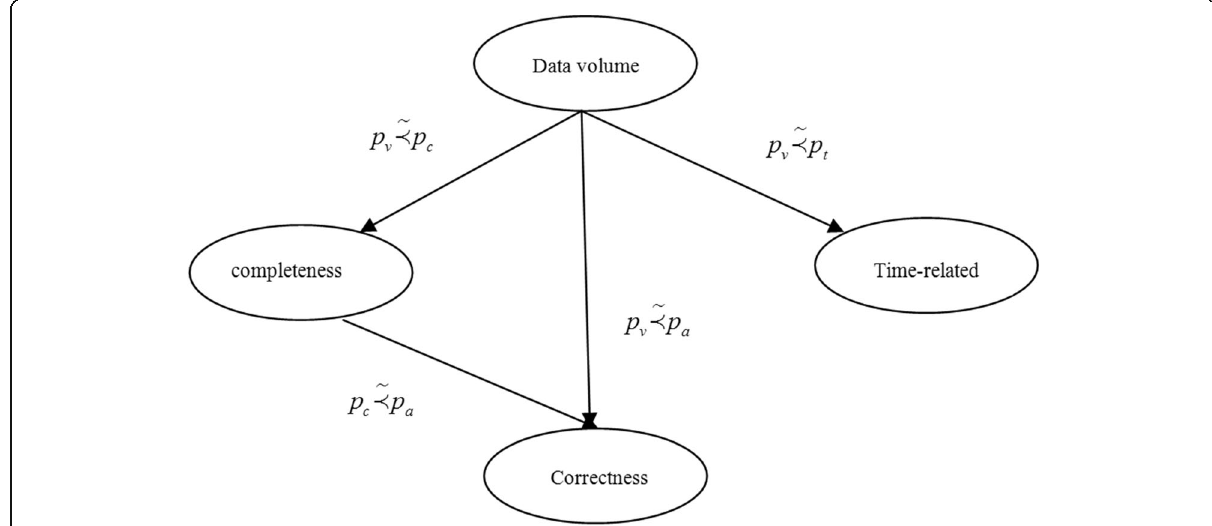
Fig. 3 Incomplete correlation between data quality